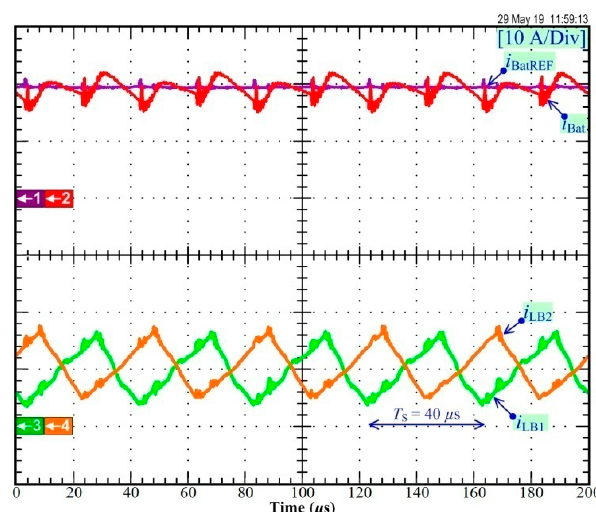
Figure 7. Steady-state waveforms of the battery converter at a discharge of 20 A.